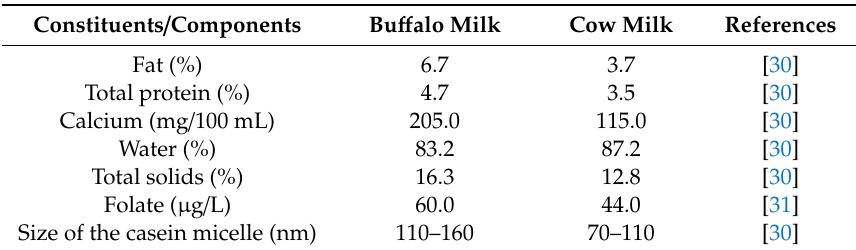
Table 2. Di ff erences between bu ff alo and cow